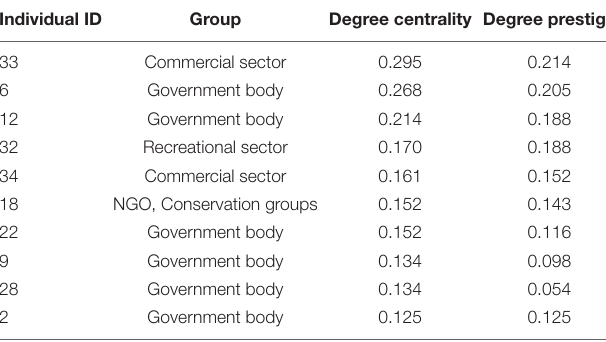
TABLE 3 | Individual identifier (ID) for the 10 stakeholders with highest degree centrality and degree prestige metrics forming the egocentric PHBSC fishery network and the groups they belong to.